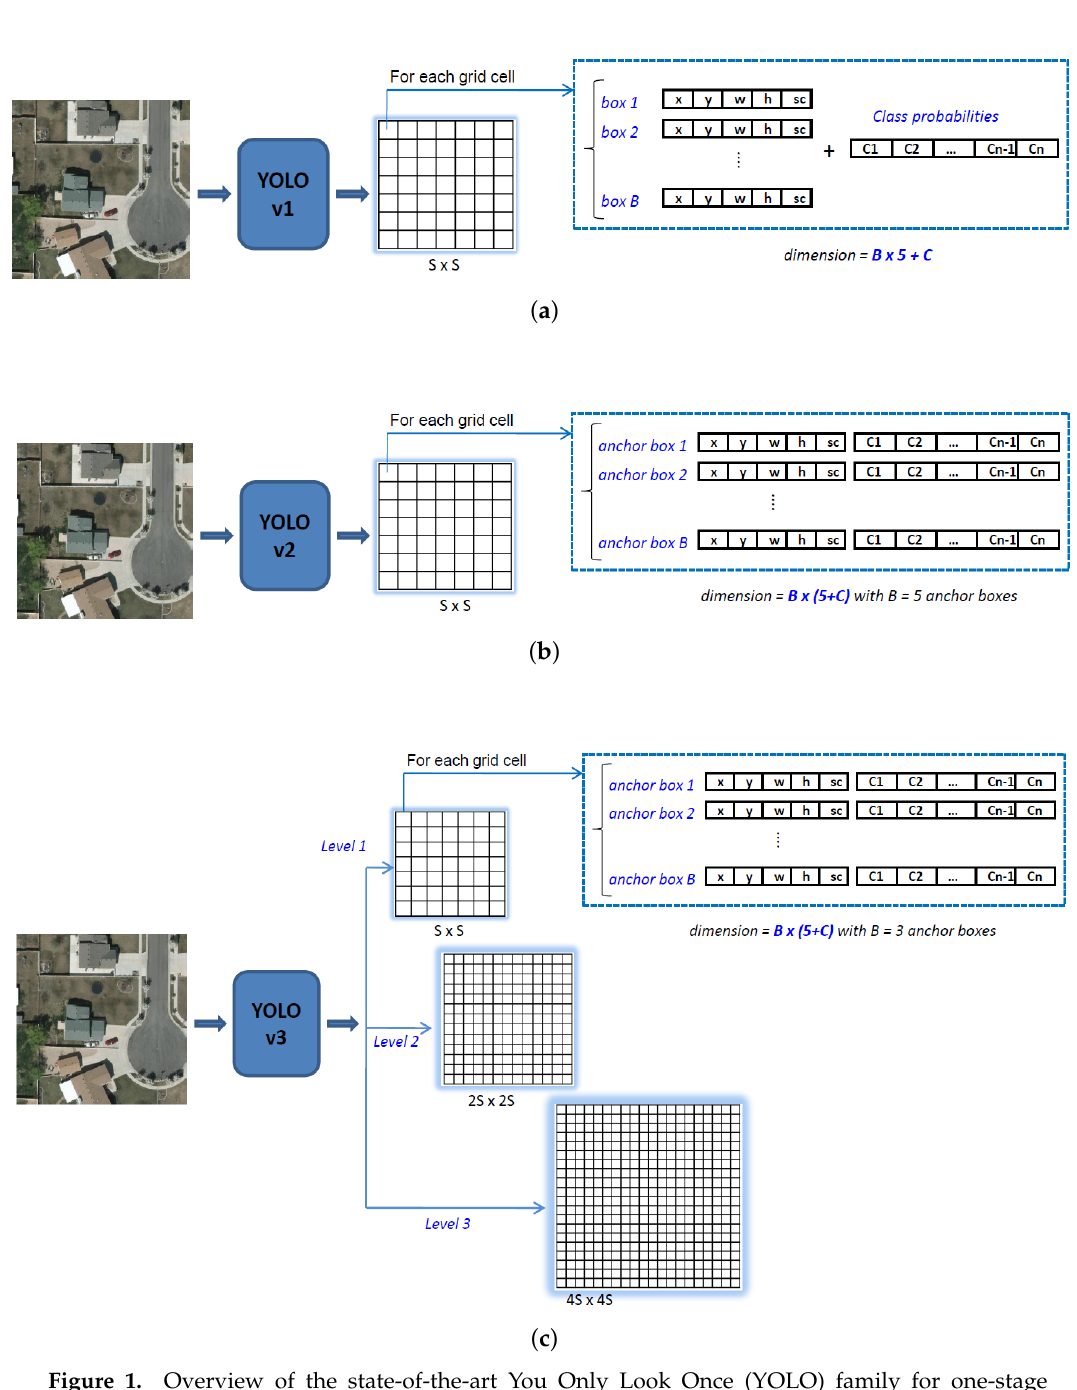
Figure 1. Overview of the state-of-the-art You Only Look Once (YOLO) family for one-stage object detection. ( a ) In YOLOv1, the output is a tensor of dimension ( S , S , B 5 + C ) with ( S , S ) × the size of the grid, B the number of predicted boxes for each cell and C the number of classes. By default in [10], S = 7, B = 2 and C = 20 for the PASCAL VOC dataset. For an input image of size 448 448 pixels, the output is a tensor of size 7 7 30. ( b ) In YOLOv2, the output is a × × × ( 5 + C )) . The difference is that the class probabilities are calculated for tensor of dimension ( S , S , B × each anchor box. By default in [11], S = 13, B = 5 anchor boxes and C = 20 for the PASCAL VOC dataset. For an input image of size 416 416 pixels, the output is a tensor of size 13 13 125. ( c ) In × × × ( 5 + C )) , ( 2 S ,2 S , B ( 5 + C )) and YOLOv3, the output consists of 3 tensors of dimension ( S , S , B × × ( 4 S ,4 S , B ( 5 + C )) which correspond to the 3 detection levels (scales). By default in [12], S = 13, B = 3 × anchor boxes and C = 80 for the COCO dataset. For an input image of size 416 416 pixels, the outputs × are three tensors of size 13 13 255, 26 26 255 and 52 52 × × × × × ×